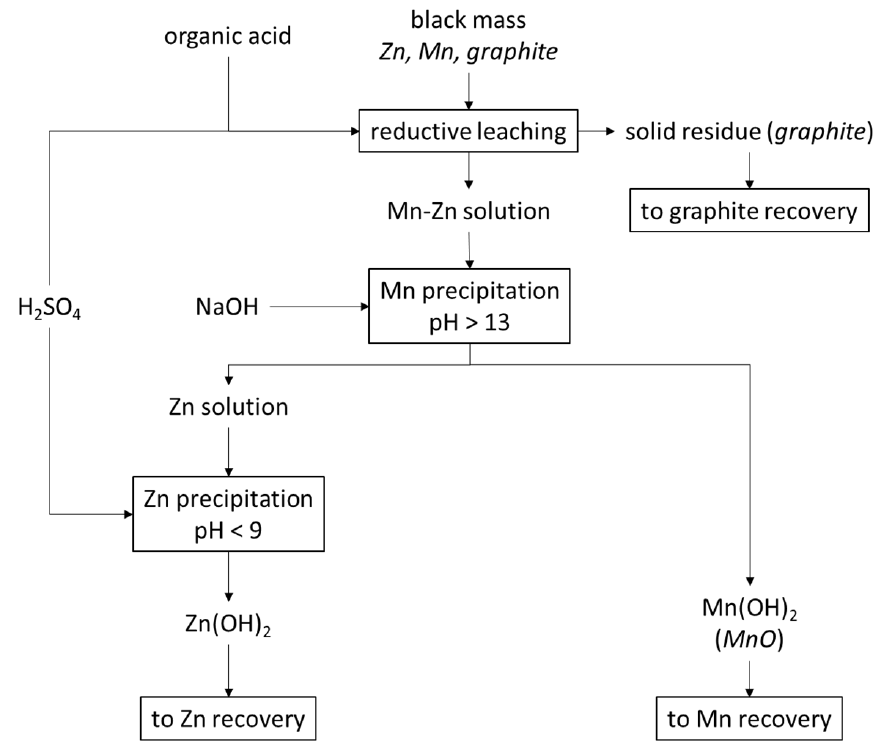
Figure 2. Proposal of hydrometallurgical treatment by non-selective leaching of alkaline batteries’ black mass for zinc, manganese and graphite recovery.